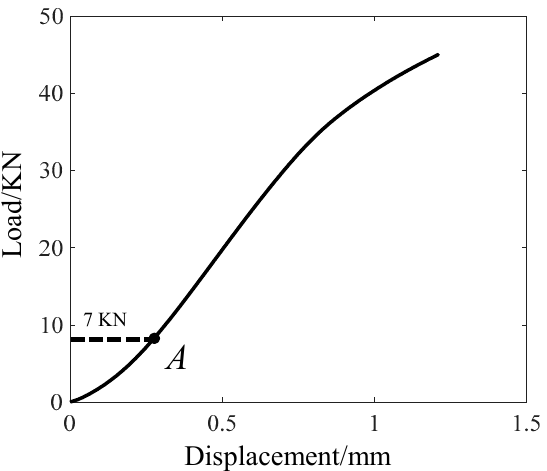
Figure 13. Load–displacement curve of indenter in diametrical compression test. Figure 13